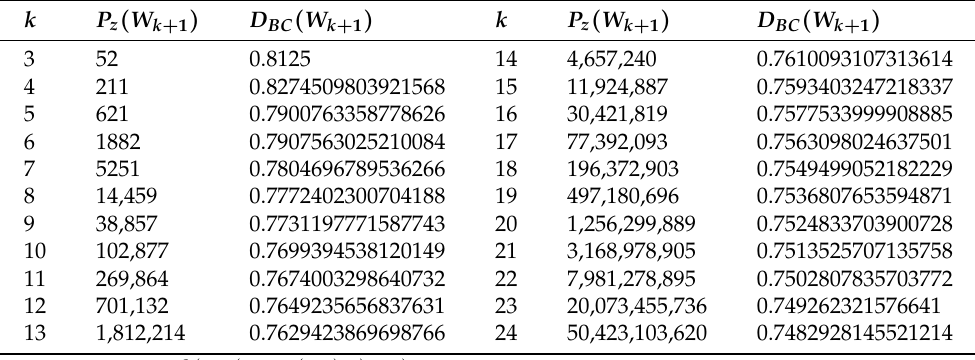
Figure 6. BC-subtree densities of wheel graph W n + 1 ( 3 Table 3. Data related to BC-subtrees of wheel graph W n + 1 ( n = 3,4 . . . ,24 )